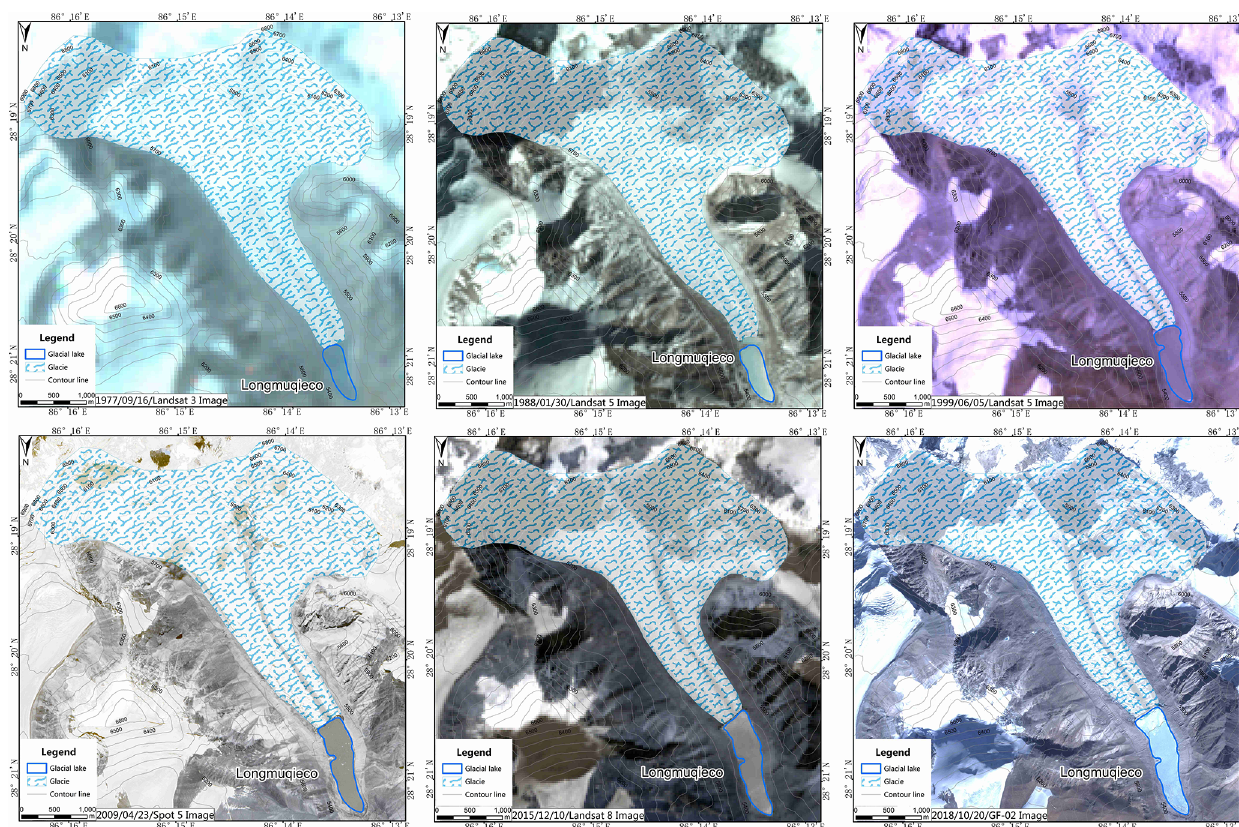
Figure 6. A comparison of the area change between the Longmuqieco Lake and its connected glacier.